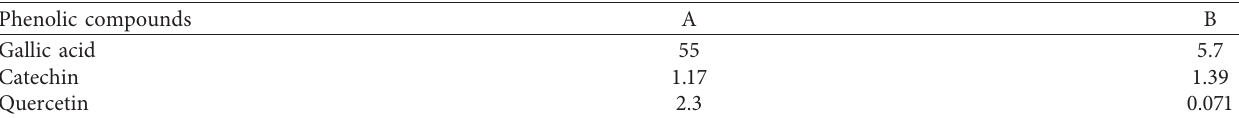
Table 7: Comparison of the amount of phenolic compounds (mg/g dried material) in Pistacia vera L. hull in this study (A) and in a similar study (B) [52].